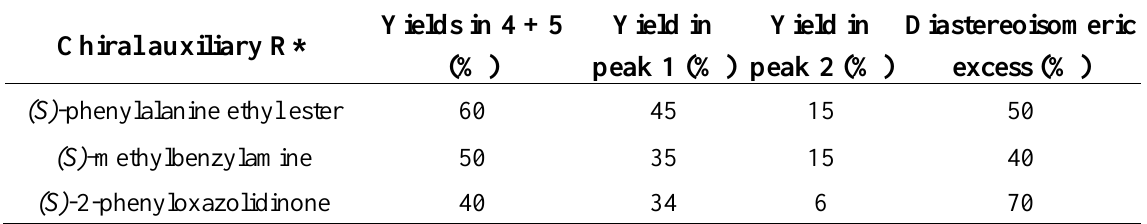
Table 1 . The enantioselective oxidative phenol coupling with chiral sinapamides.